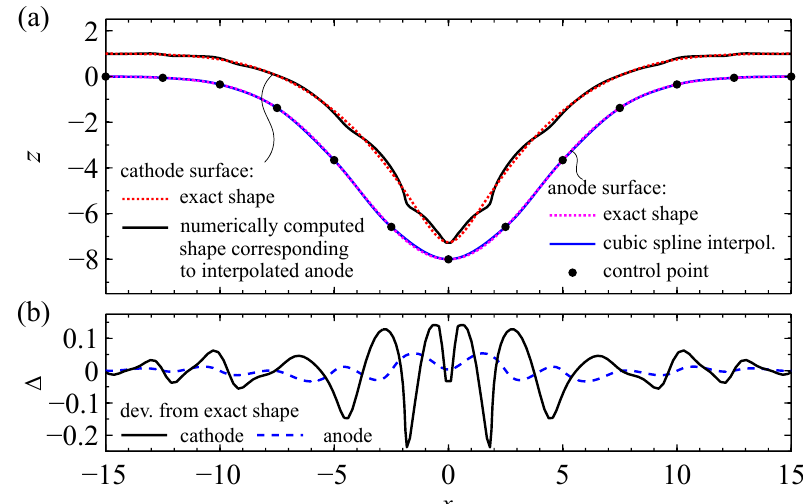
Figure 9. Cathode shape design for an anode interpolated by cubic splines (spatial dimensions are normalized to the width of the standard equilibrium front gap). The exact surface profile of the anode (dashed curve) in Panel ( a ) is defined by Equation (17) with A = 8 and σ = 4; the surface profile of the “perturbed” anode (solid curve) is obtained by a cubic spline interpolation connecting 13 control points on the exact anode. The numerically calculated cathode to “perturbed” anode is obtained after 800 iterations at step length τ = 0.4. The interelectrode gap is discretized by a 200 × 20 mesh. Panel ( b ) shows the deviation of the “perturbed” electrode shapes from the exact shapes in surface normal